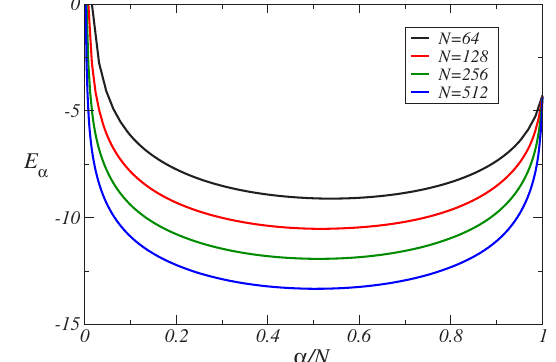
FIG. 4. Optimal profile f E α g for which the product C ϵ 2 is